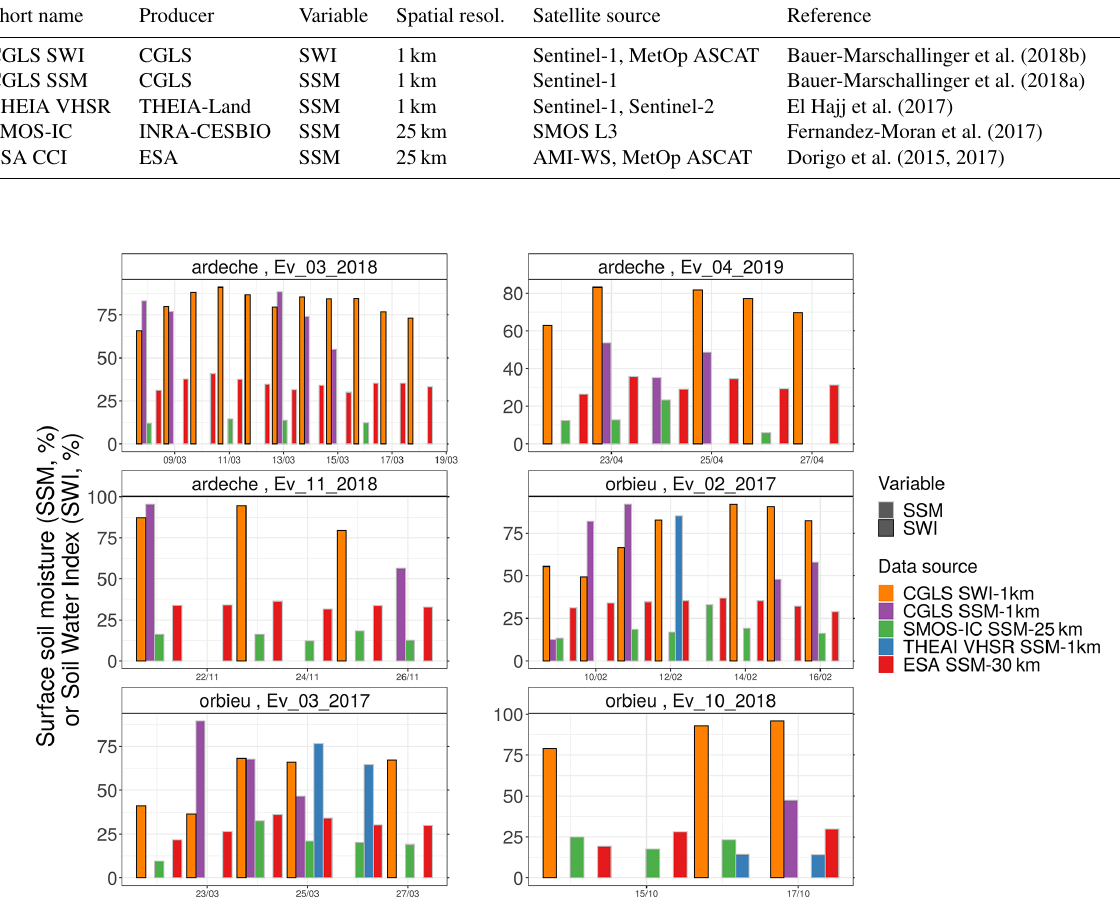
Figure A1. Daily values of Surface Soil Moisture (SSM) or Soil Water Index (SWI) provided by the CGLS, SMOS-IC, THEIA-Land VHSR, and ESA CCI products, on average, over the two studied catchments during the six simulated